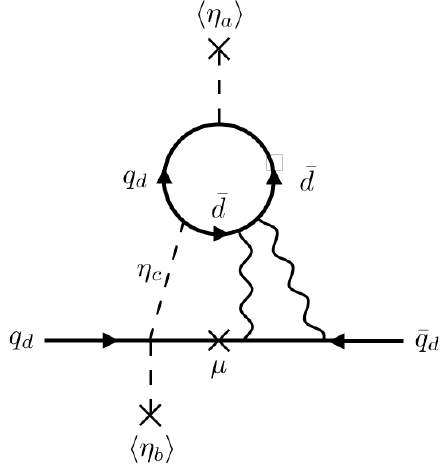
Figure 5 . An example diagram contributing to ¯ θ . The wavy lines denote the SM gauge